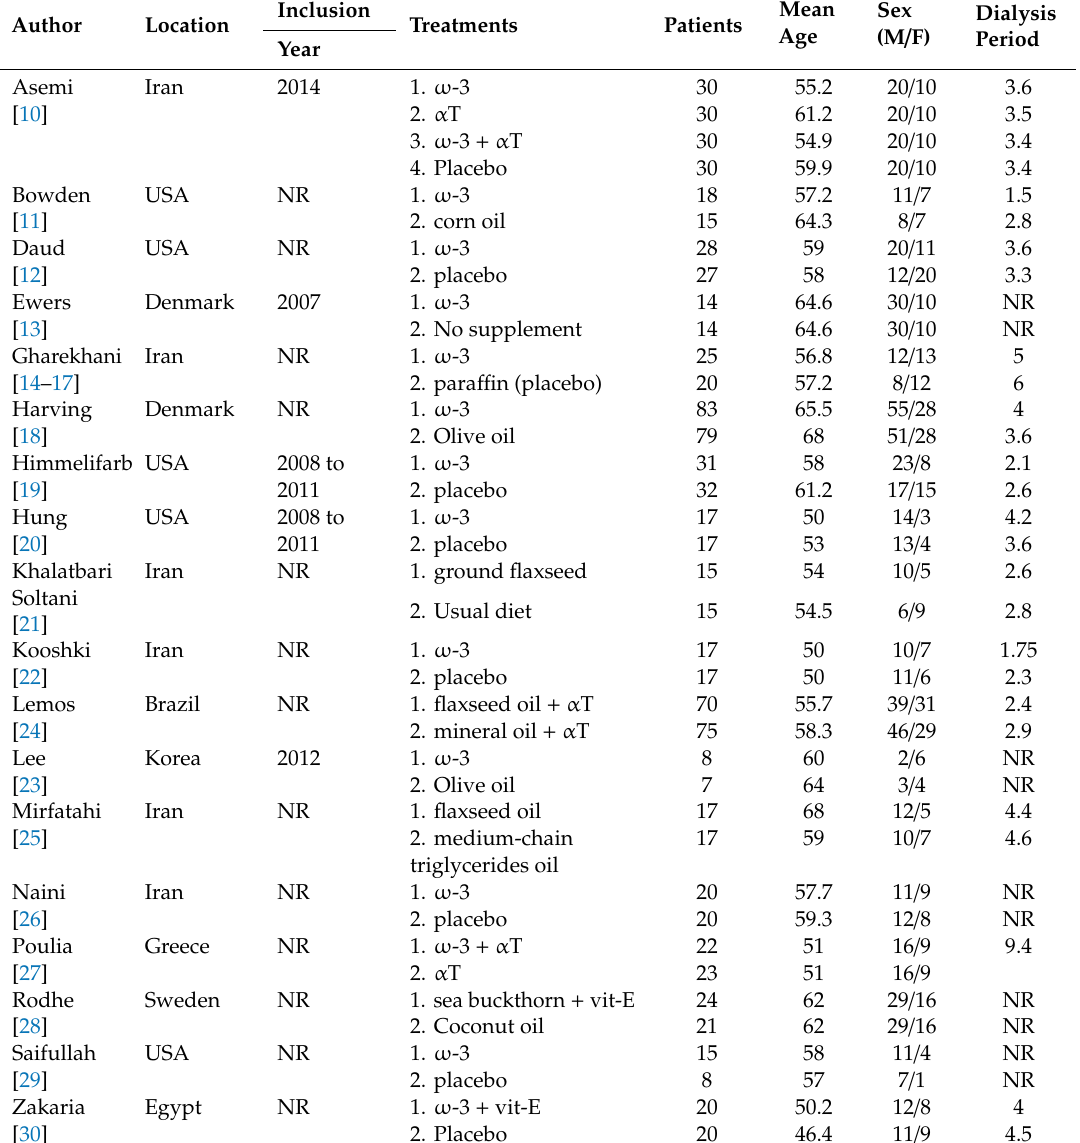
Table 1. Characteristics of the included randomized clinical